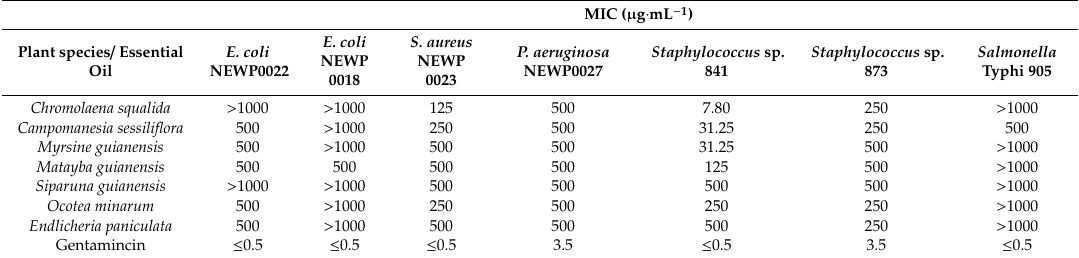
Table 1. Minimum inhibitory concentration values (MIC, µ g · mL − 1 ) of the essential oils obtained from the leaves of Chromolaena squalida , Campomanesia sessiliflora , Myrsine guianensis , Matayba guianensis , Siparuna guianensis , Ocotea minarum and Endlicheria paniculata against standard strains of S. aureus , E. coli and P. aeruginosa , and clinical isolated resistant strains *. MIC ( µ g · mL − 1 ) E. coli Plant species / Essential Oil NEWP0022